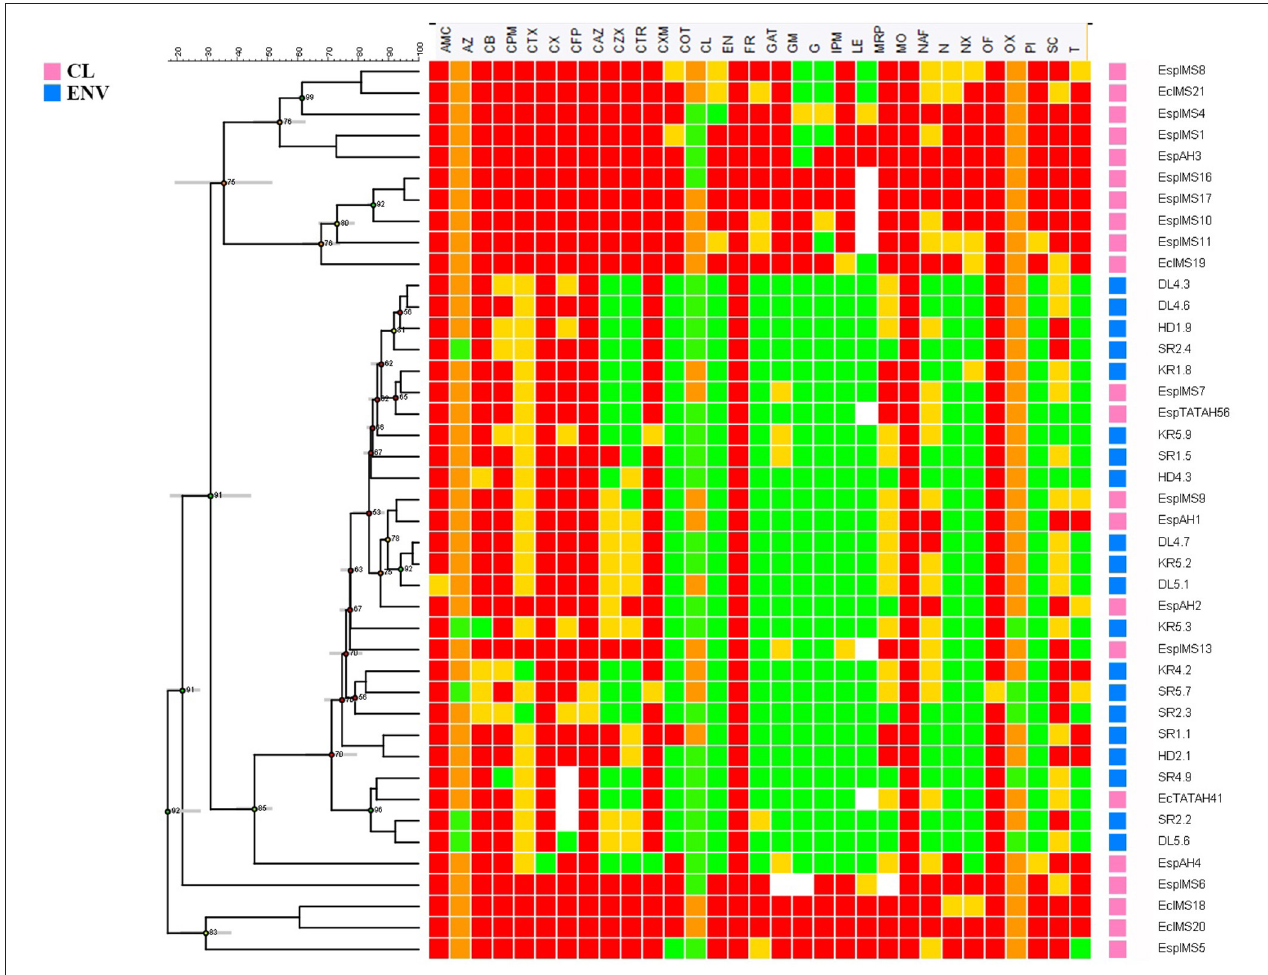
FIGURE 1 | Comparative antibiotic susceptibility profile of environmental and clinical Enterobacter isolates. Antibiotic susceptibility of environmental ( n = 20) and clinical ( n = 22) Enterobacter isolates toward 40 different antibiotics belonging to different classes was performed by disk diffusion method. Zone of inhibition was recorded to represent the Resistant (Red), Intermediate (Yellow) and Susceptible (Green) isolates. The antibiogram profiles of all these isolates are represented here as a heat map with dendrogram, which was generated using Bionumerics v7.0